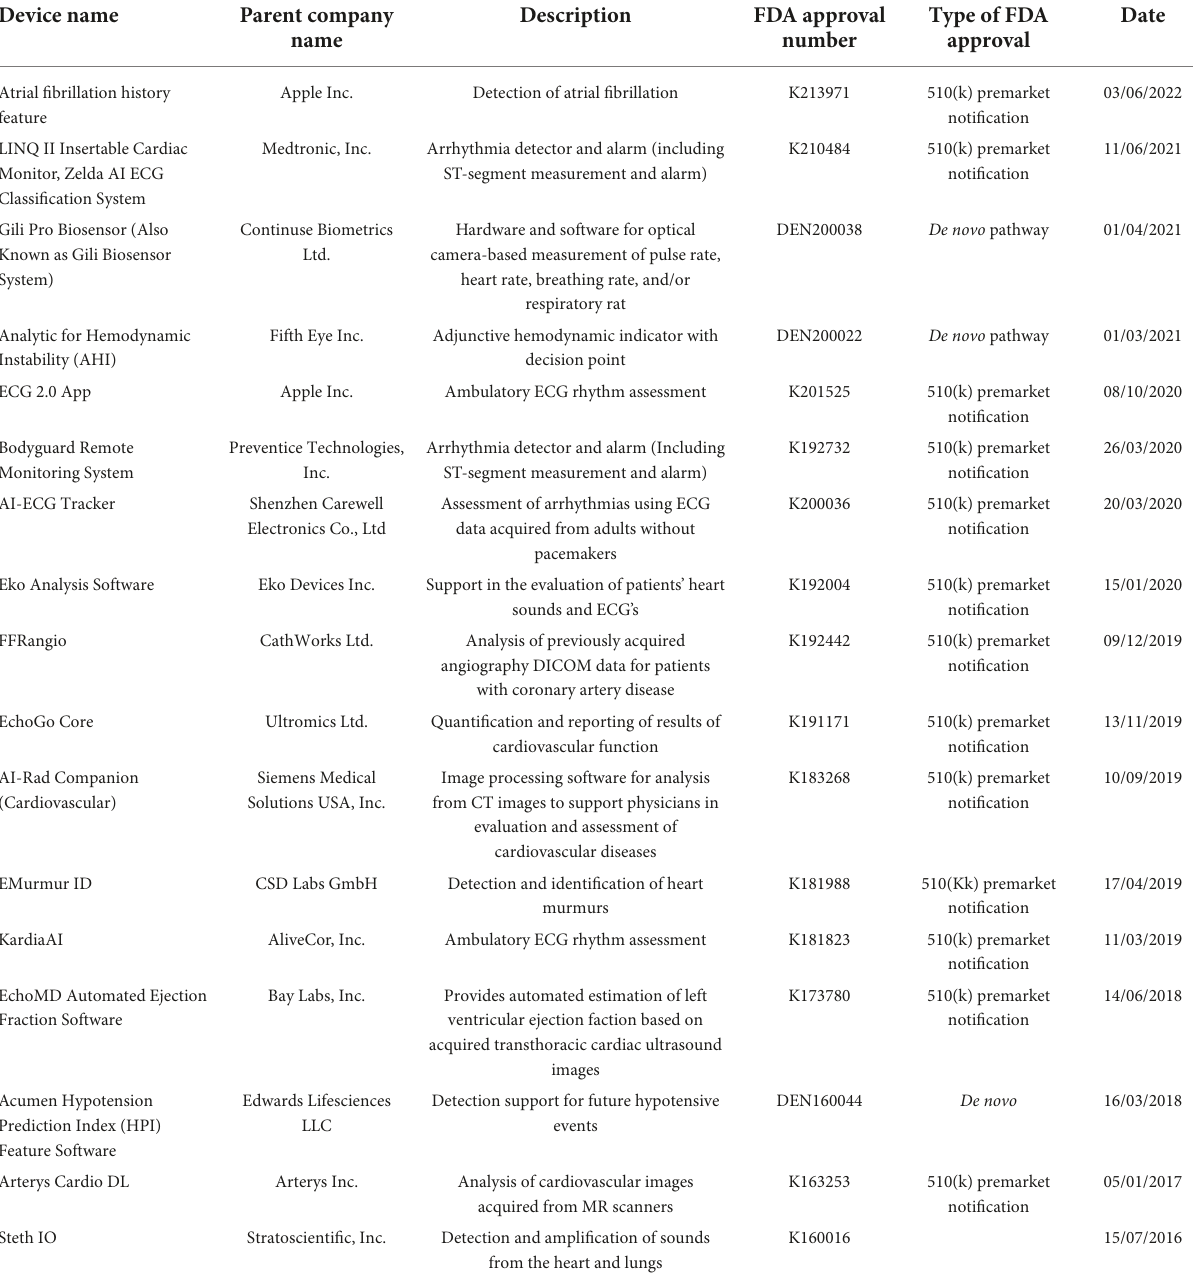
TABLE 4 FDA approved AI/ML based medical